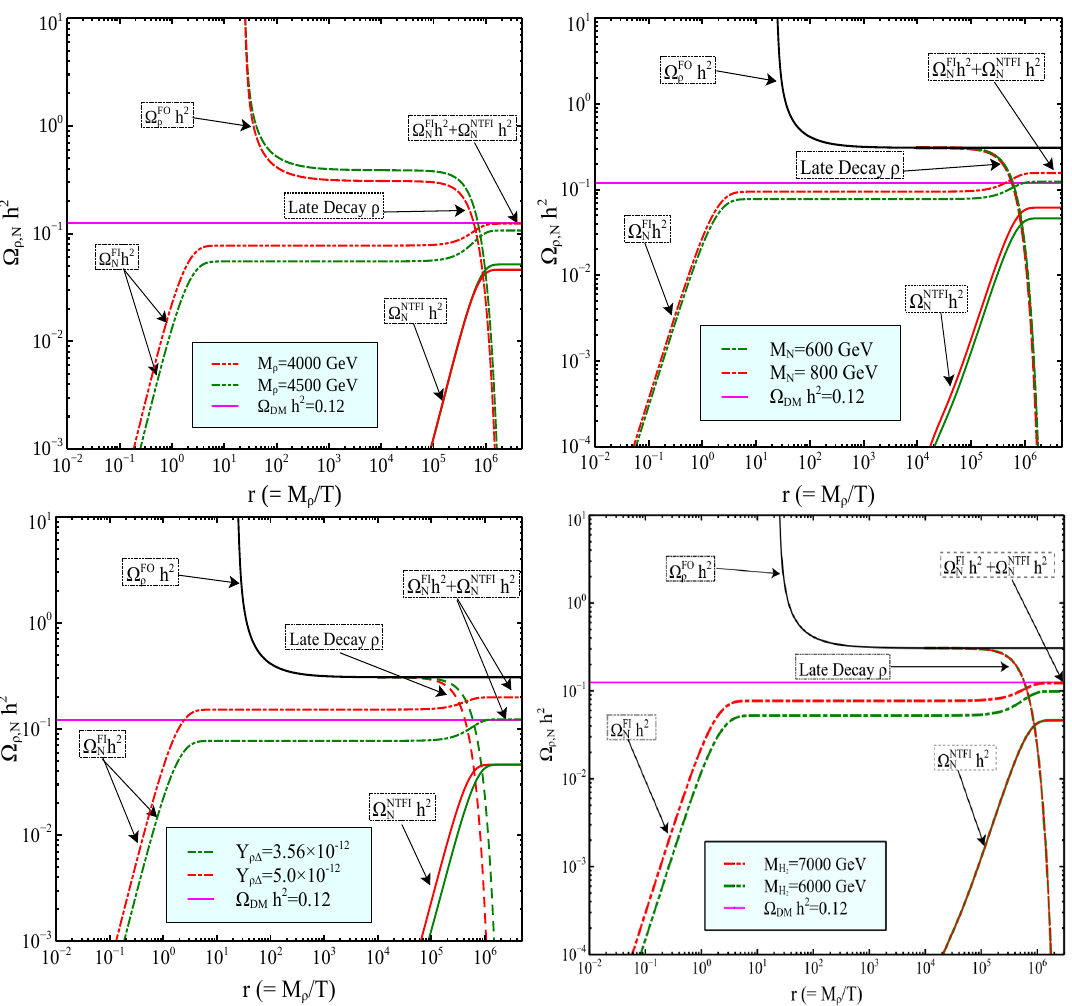
Figure 14 . Upper panel shows the variation of DM and ρ abundance for different values of M ρ,N . In upper RP, the topmost curve ( Ω FO h 2 ) corresponds to M ρ = 4500 GeV and lowermost ρ curve corresponds to M = 4000 GeV. Whereas in upper LP, the lowermost and topmost curve ρ of ( Ω FI h 2 ) corresponds to dark matter mass 600 GeV and 800 GeV respectively. In the lower N panel figures, we show the variation w.r.t. different choices of Yukawa Y and M . In lower LP, H 2 ρ ∆ topmost and lowermost curve ( Ω FI h 2 ) corresponds to Y ρ ∆ = 5 . 0 × 10 − 12 and Y ρ ∆ = 3 . 56 × 10 − 12 N respectively. In lower LP, topmost curve of Ω FI = 7000 GeV. The following h 2 corresponds to M H N 2 model parameter are kept fixed to, M = 4000 GeV, M = 600 GeV, M = 7000 GeV and ρ N H 2 Y ρ ∆ = 3 . 56 × 10 − 12